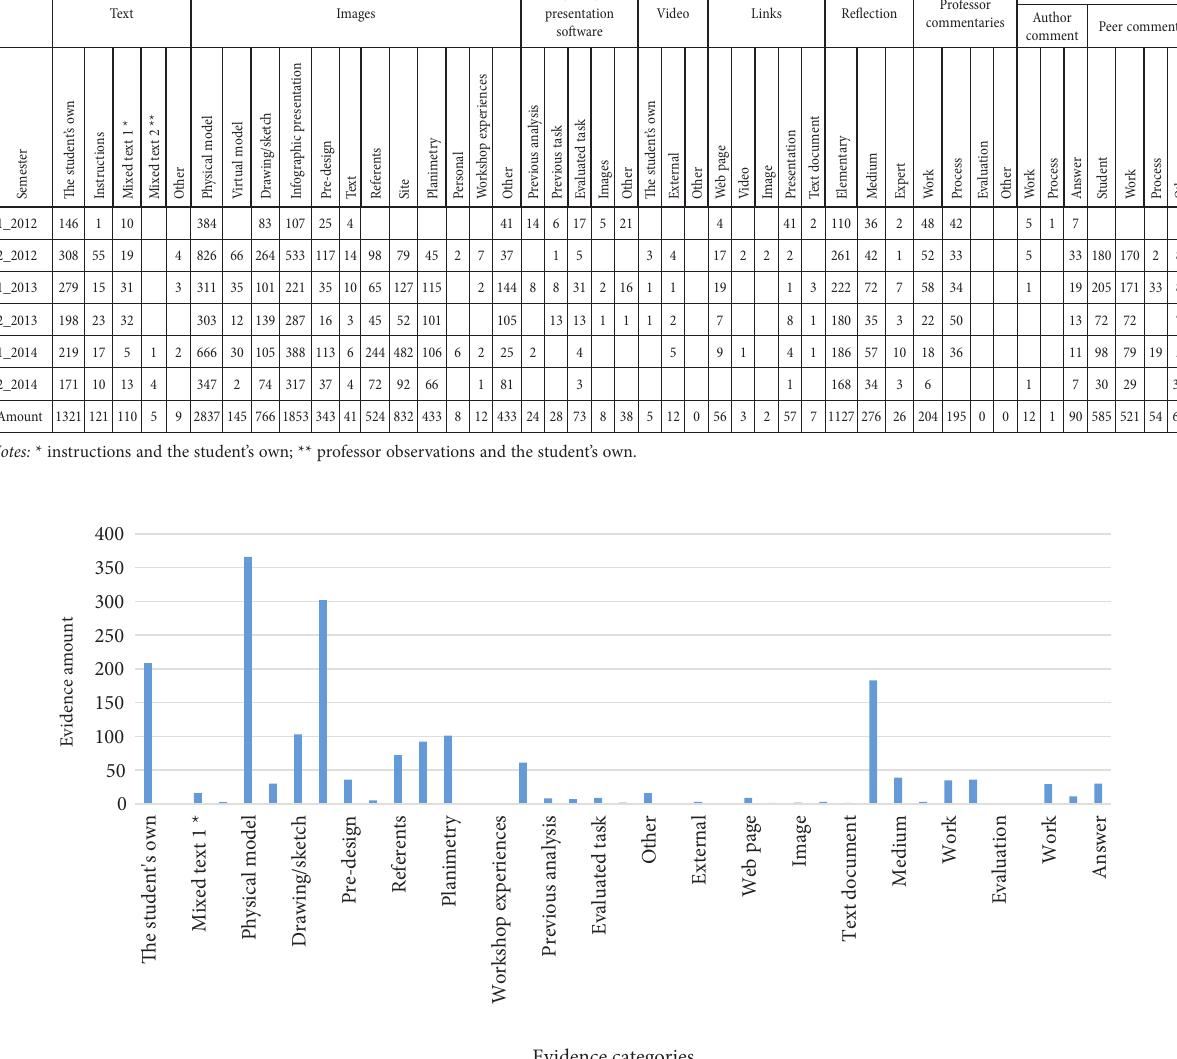
Table 7. Detailed quantification of the evidences contained in the e-portfolios (source: Authors, 2019) Text Images